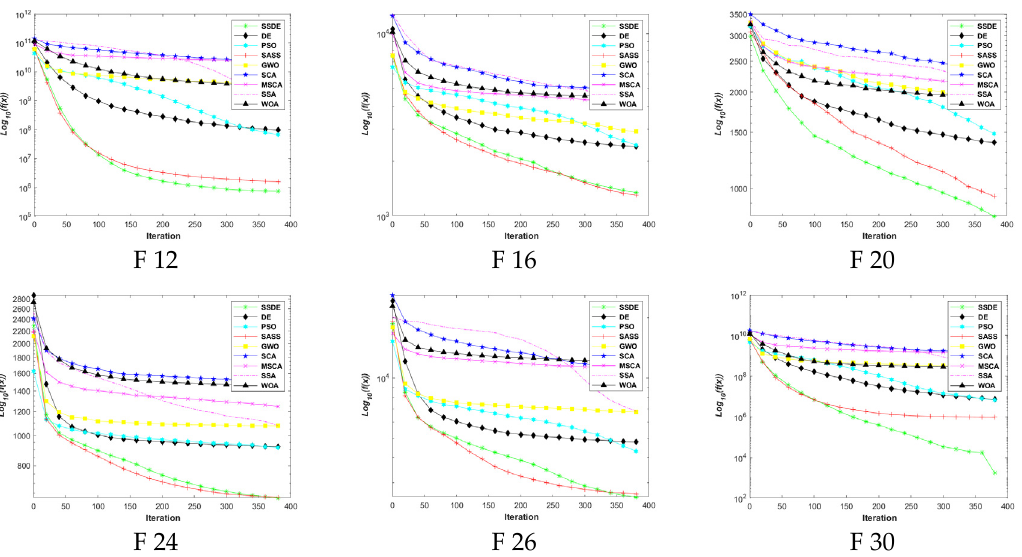
Figure 6. Evolutionary curves of SSDE, DE, PSO, SASS, GWO, SCA, MSCA, SSA, and WOA on the CEC 2017 test functions in 50 dimensions.